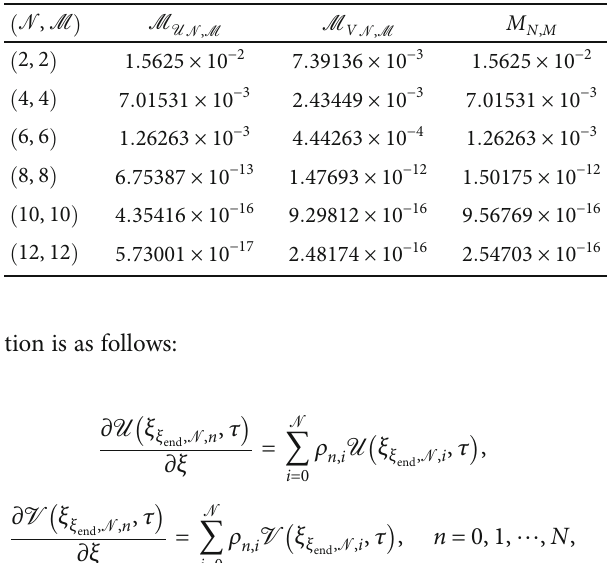
Table 1: Maximum absolute errors of Equation